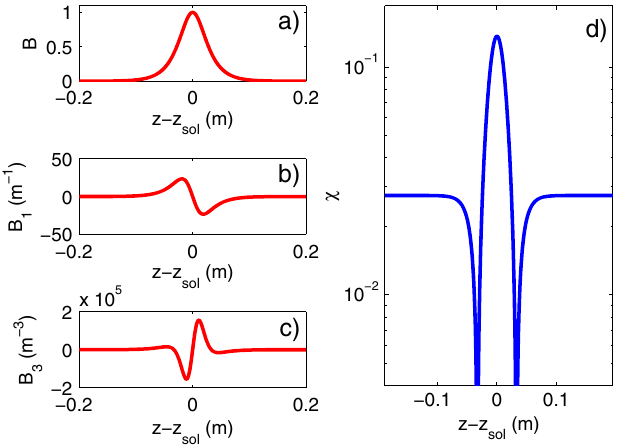
FIG. 3. (Color) Axial normalized magnetic field of L3 (a), first B (cid:3) @B (cid:3) @ 3 B (b), and third B (c) derivatives and nonlinear- @z 1 3 @z 3 over-linear focusing ratio (cid:8) computed at r ¼ 1 cm (d). In plot (a) both the magnetic field obtained from POISSON simulation (blue) and its analytical approximation (red) are shown. The analytical function is ~ B ð z Þ ¼ 1 = cosh ð z= 0 : 0214 Þ . The horizontal axes of all the plots have their origins coincident with the ’ 0 : 57 m from the solenoid’s center located at z sol